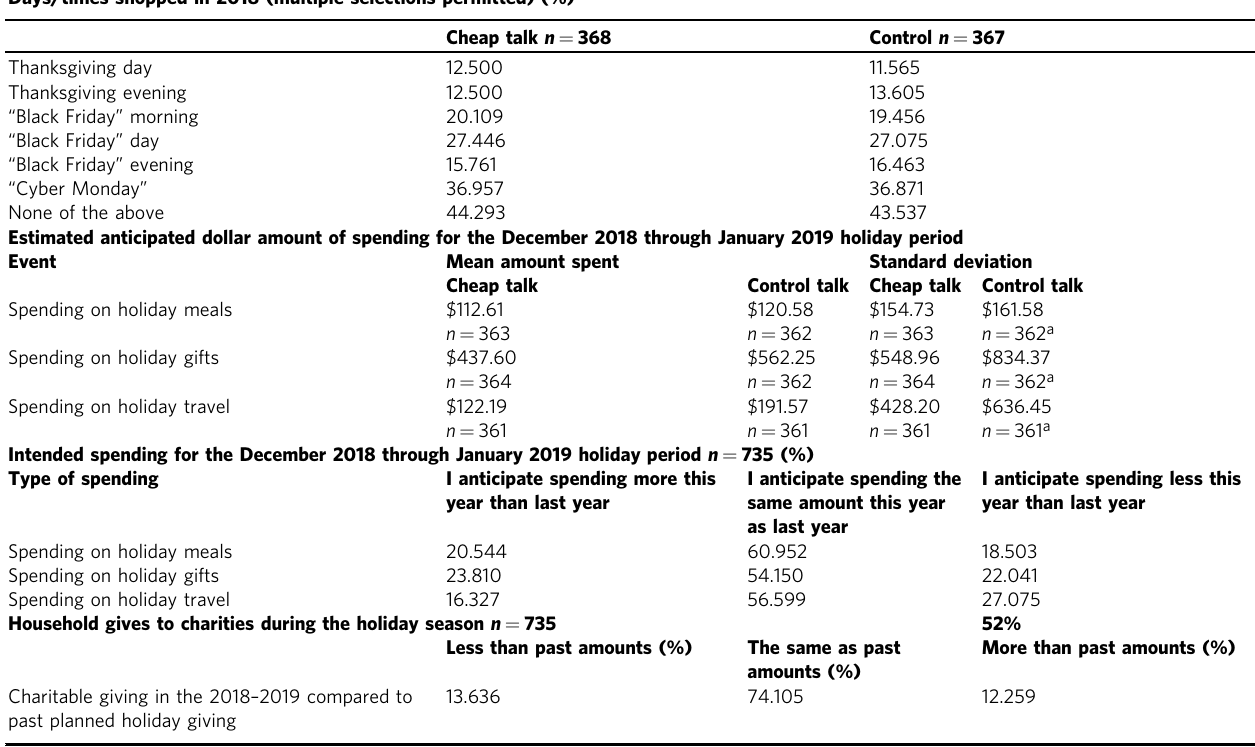
Table 2 Respondent holiday spending behavior. Days/times shopped in 2018 (multiple selections permitted)